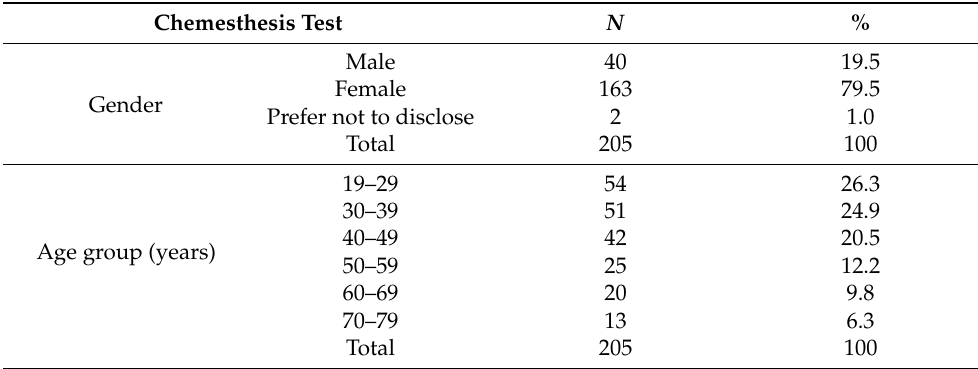
Table 2. The subject’s demographical information and classification from those who attended to evaluate all chemesthetic samples ( N =